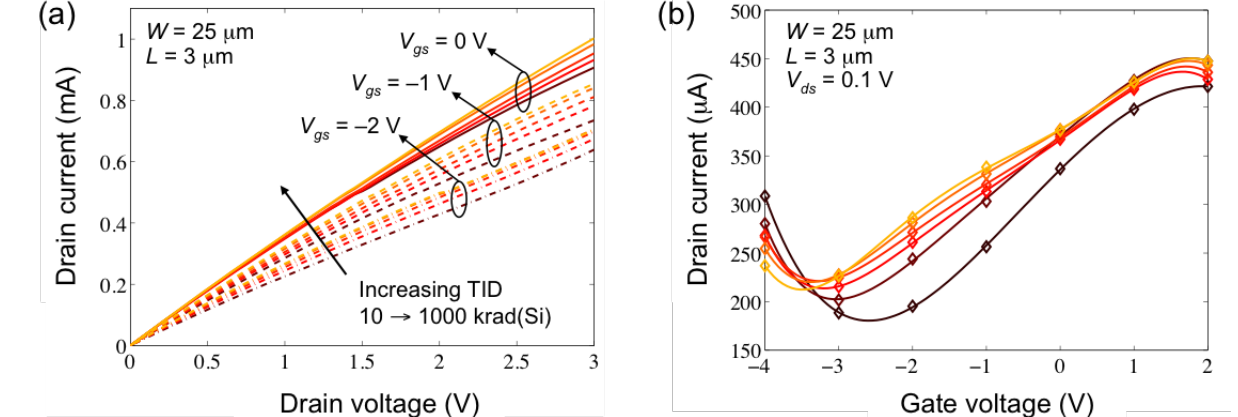
= V − V ) and minimum conductivity Dirac Dirac Dirac 0 = 0.1 V in Figure 3b. Note: V = −2.58 V, σ ds Dirac 0